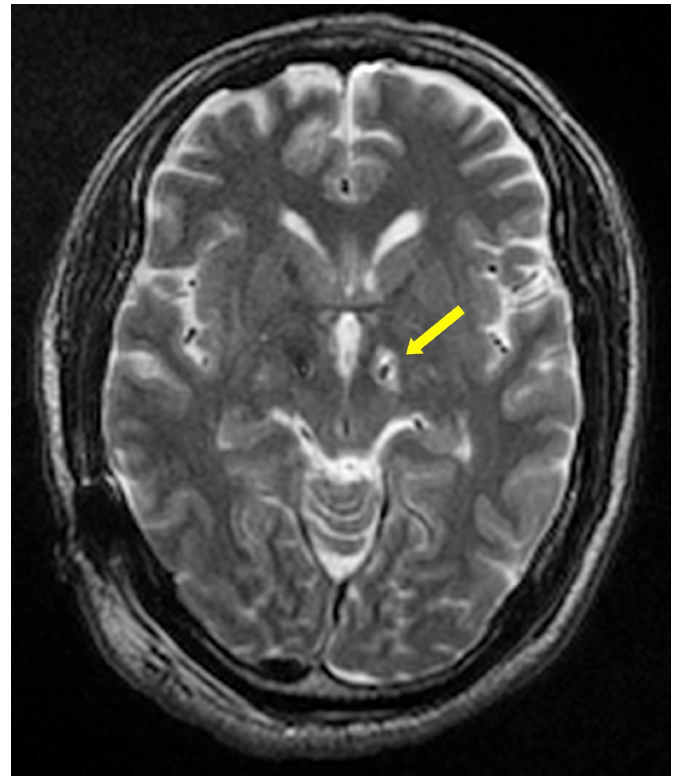
Figure 2. The yellow arrow indicates limited non ‐ infectious peri ‐ electrode edema in deep white matter on postoperative T2 ‐ MRI image.